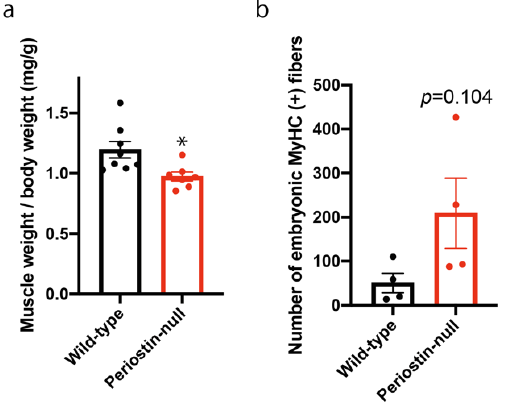
cle weight 7 days after the induction of muscle regeneration. n = 7–8. ( b ) Number of embryonic MyHC-positive fibers 14 days after the induction of muscle regeneration. n = 4. * p < 0.05 by Student’s t -test. Error bars indicate